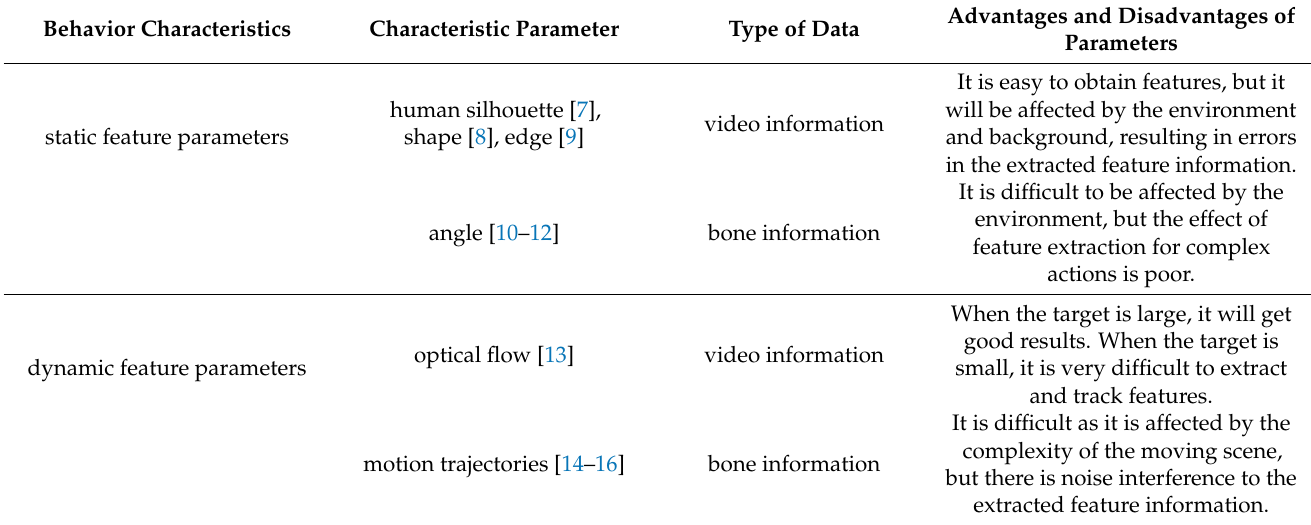
Table 1. Comparison of behavior feature extraction